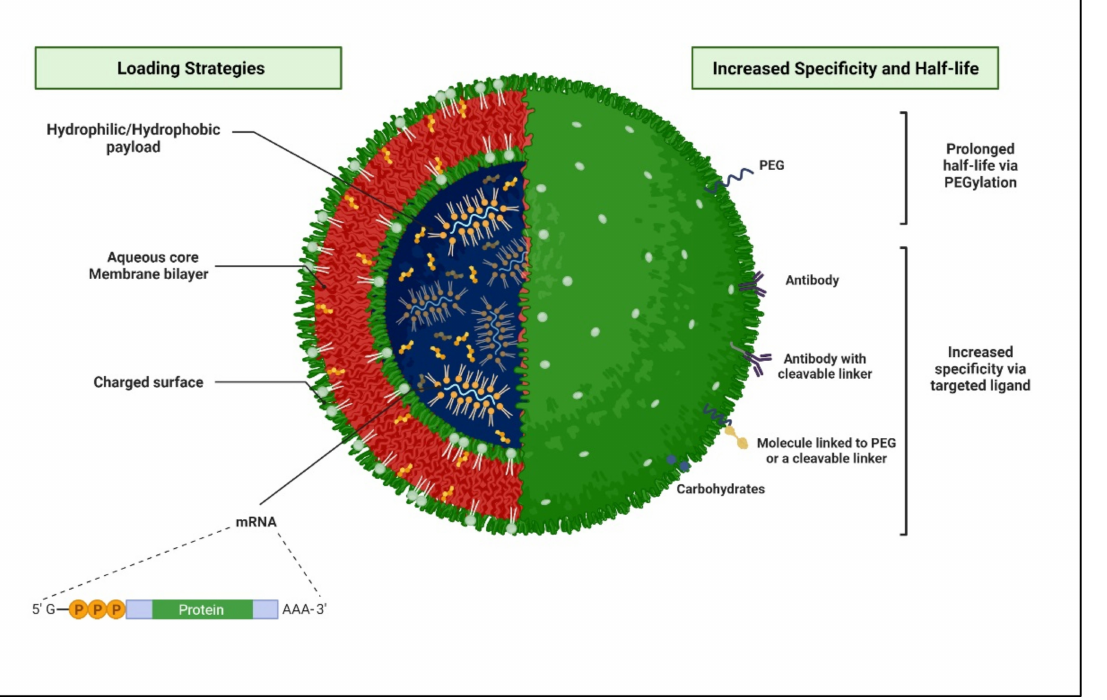
Figure 8. Schematic 3D representation of a structural arrangement of a liposome and various loading strategies, which are leading to enhancing the specificity and half-life of the nanocarrier at the targeted HIV-infected sites. (Created with BioRender.com (accessed on 19 June